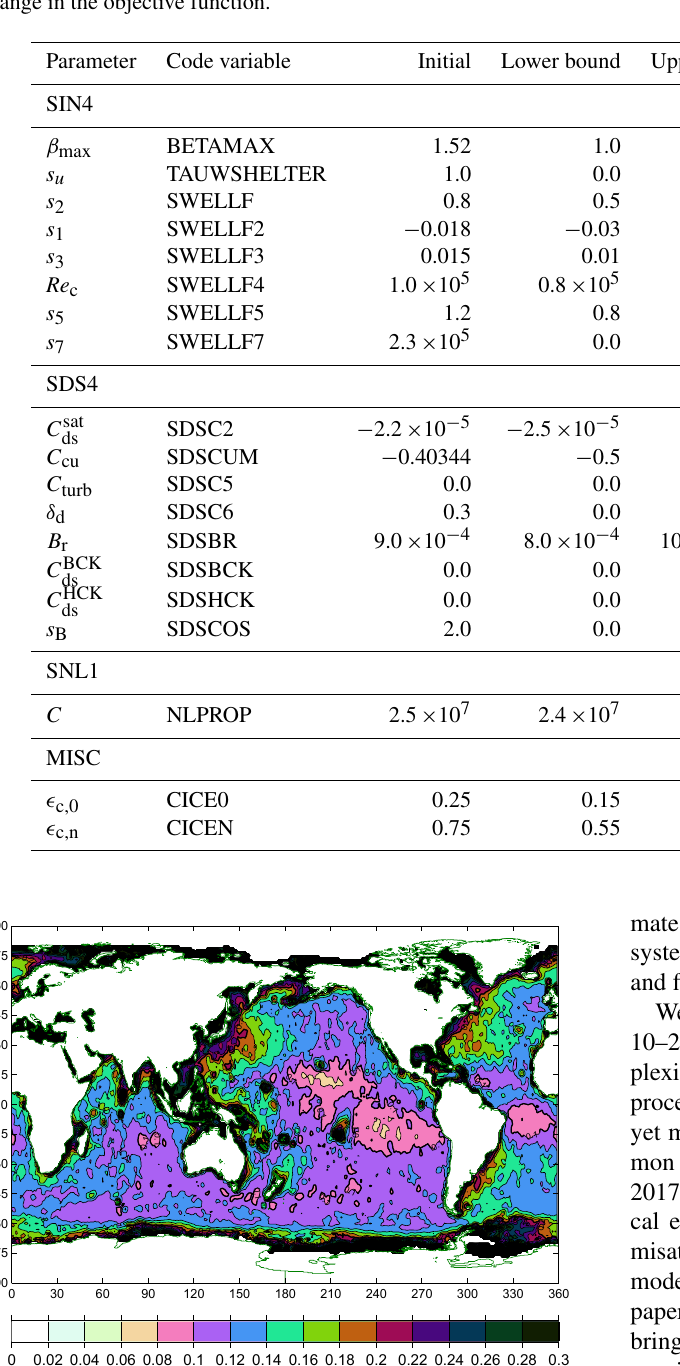
Table 6. As for Table 3 but for parameters used to calibrate the simulation using the source term package of Ardhuin et al. (2010), for January– December 1997. The delta value in the seventh column is the estimated change in the (un-normalised) parameter required to produce a 0.1% change in the objective function.